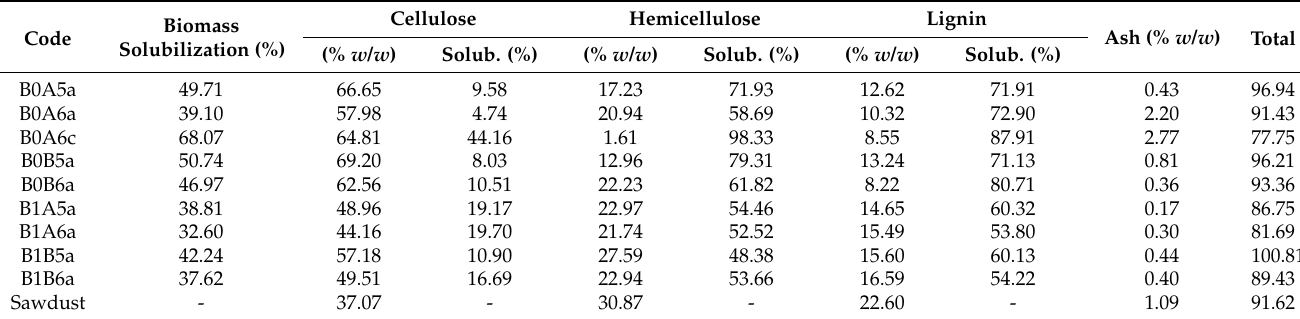
Table 1. Biomass composition of solids following organosolv